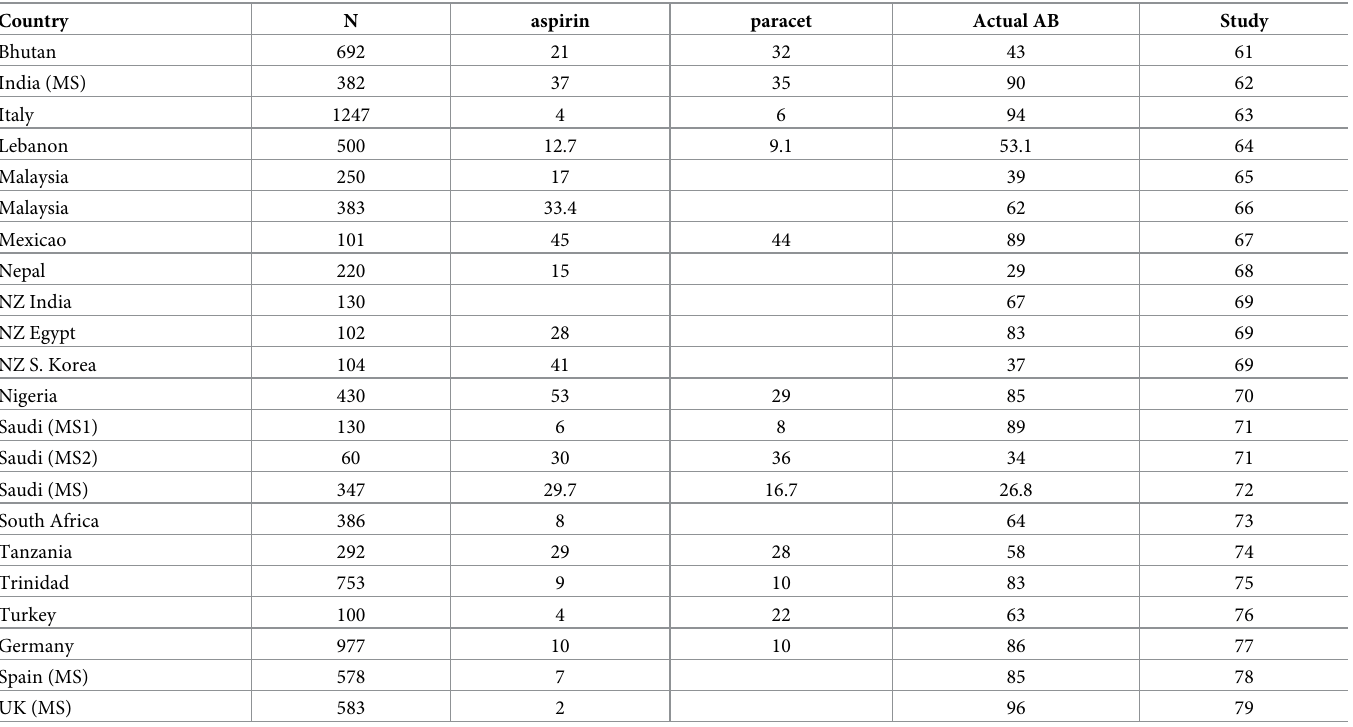
The country is given in the “Country” column. (MS) indicates medical students. The New Zealand survey included people who migrated to New Zealand from